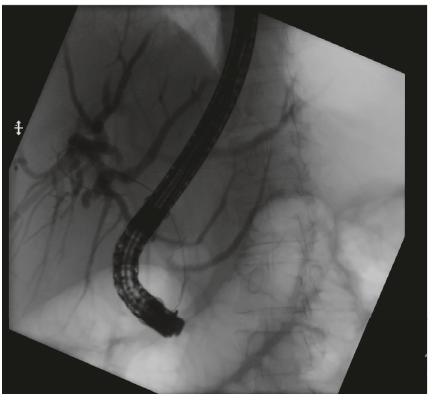
Figure5:Endoscopicretrogradecholangiopancreatography(ERCP) fluoroscopic image showing dilated intrahepatic ducts with absence of filling on the common bile duct (evidenced by the